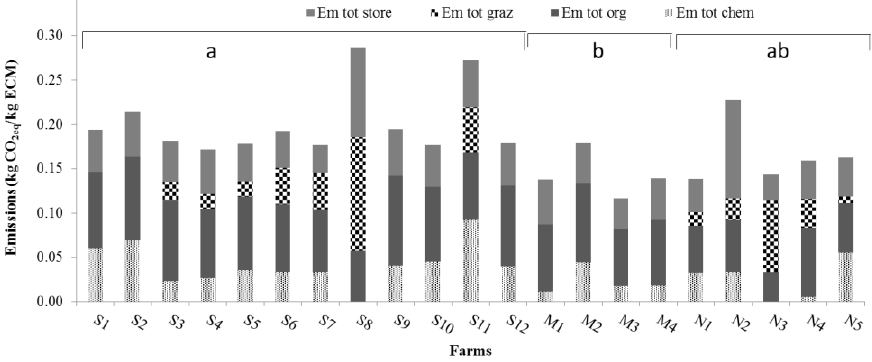
Figure 5. Total N 2 O emissions, expressed as kg CO 2eq kg − 1 ECM, calculated per farm and grouped as storage, grazing and organic and chemical fertilisation. Regions are specified as south (S), central (C) or north (N). Letters at the top of the bars show significant differences among the mean values per region (α = 0.05).